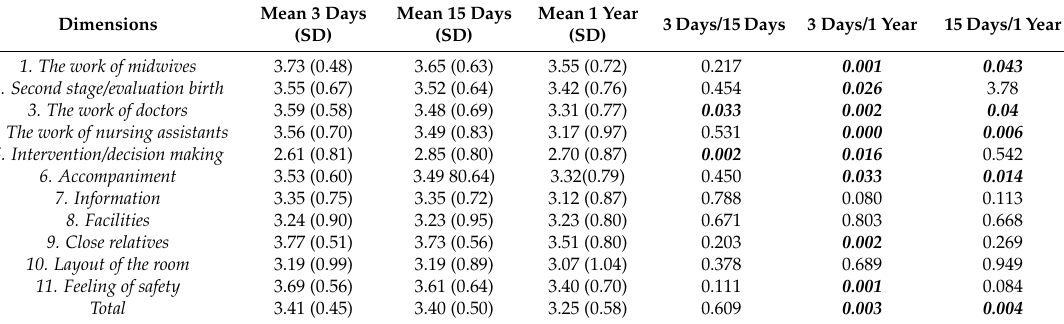
Table 2. Mean scores for each dimension at each time point when the questionnaire was delivered (left), and p values of the comparisons between each time point when the questionnaire was delivered